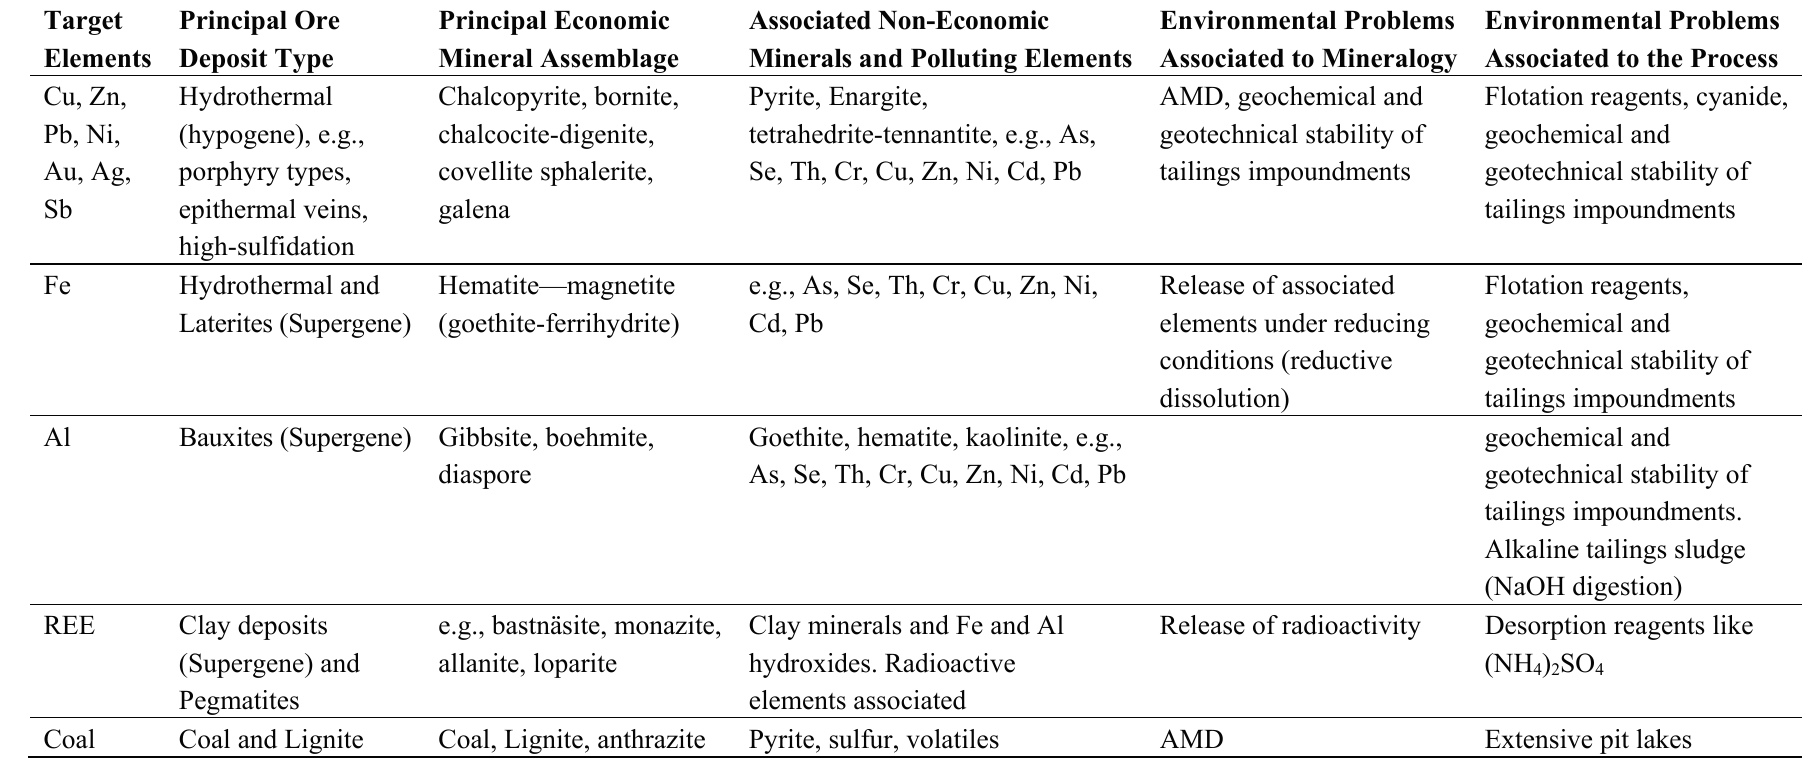
Table 1. Simplified overview of the principal elements extracted by mining and their associated ore deposit type and with the associated environmentally problematic elements and their mineral assemblage. Only the principal minerals and elements are shown; this list can be much more extensive depending on the ore deposit. Hypogene: hydrothermal formation; Supergene: liberation and enrichment processes due to meteorization; AMD: acid mine drainage; REE: Rare Earth